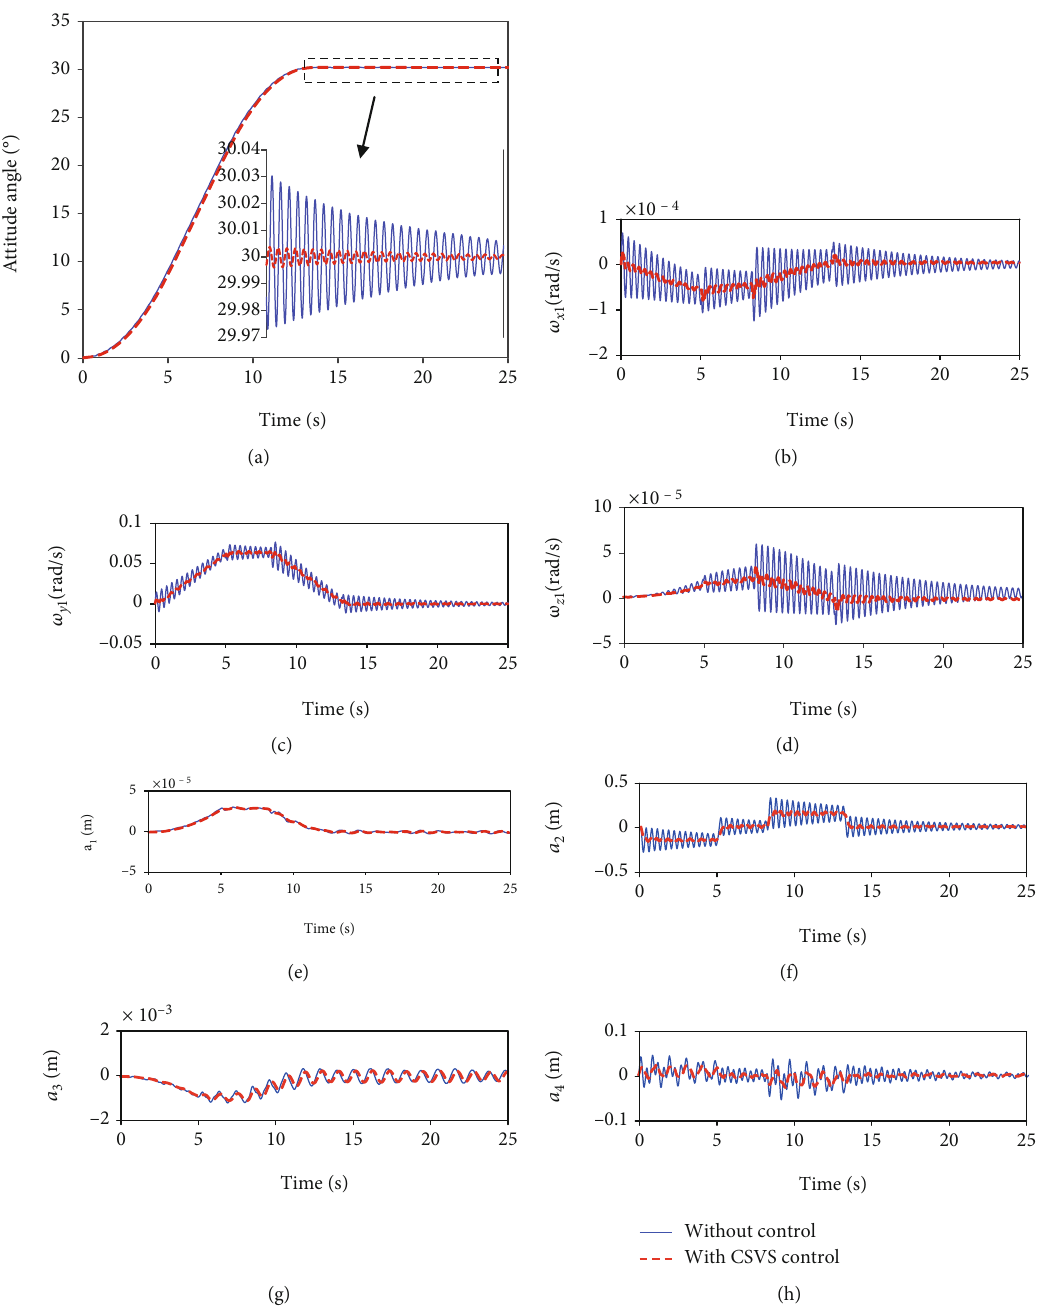
Figure 15: Dynamic response of the satellite-membrane-antenna system during the attitude maneuver with modeling disturbance under CSVS control: (a) attitude angle; (b) angular velocity in the x 1 direction; (c) angular velocity in the y 1 direction; (d) angular velocity in the z 1 direction; (e) fi rst-order modal coordinate; (f) second-order modal coordinate; (g) third-order modal coordinate; (h) fourth-order modal